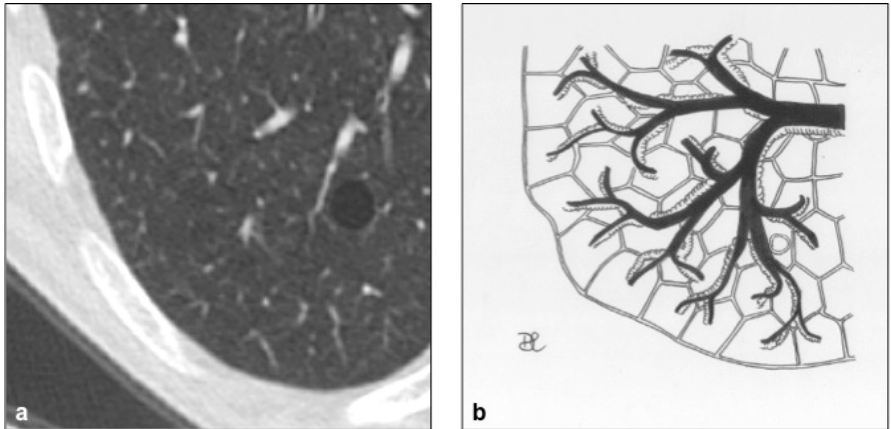
Figure 20. Aging lung cysts pattern ( a , b ). These cysts can be found in any portion of the lungs; they usually show rounded shape and they are limited by thin walls. This figure has been partially modified from ECR 2017 / C-2141 Cystic pattern in lung diseases: a simplified HRCT guide based on free-hand drawings, DC Caltabiano, V. Costanzo, L. Mammino, V. Vindigni, S. Torrisi, R. Rosso, LA